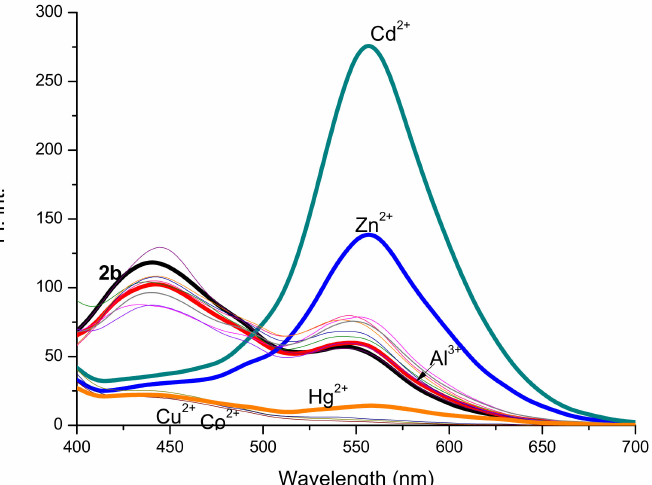
Figure 3. Fluorescence spectra of 2b (10 µ M) recorded with or without 2 equiv. of metal ions (Al 3+ , Zn 2+ , Cd 2+ , Ag + , Co 2+ , Ni 2+ , Cu 2+ , K + , Pb 2+ , Mg 2+ , Na + , Ca 2+ , Fe 2+ , Fe 3+ , and Hg 2+ ) in PBS buffer (10 mM, pH 7.2) containing 50%